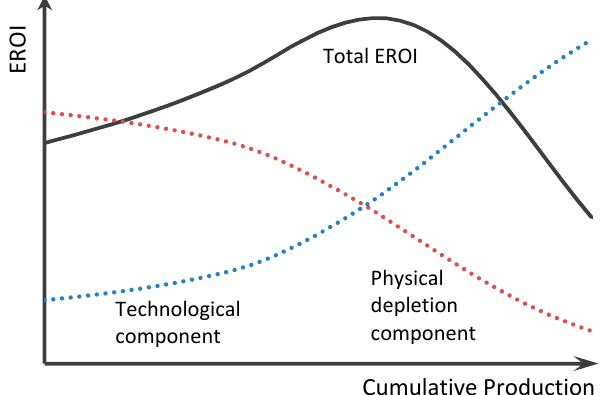
Figure 2. Dale et al. [23] proposed a dynamic function of the EROI as a function of cumulative production.